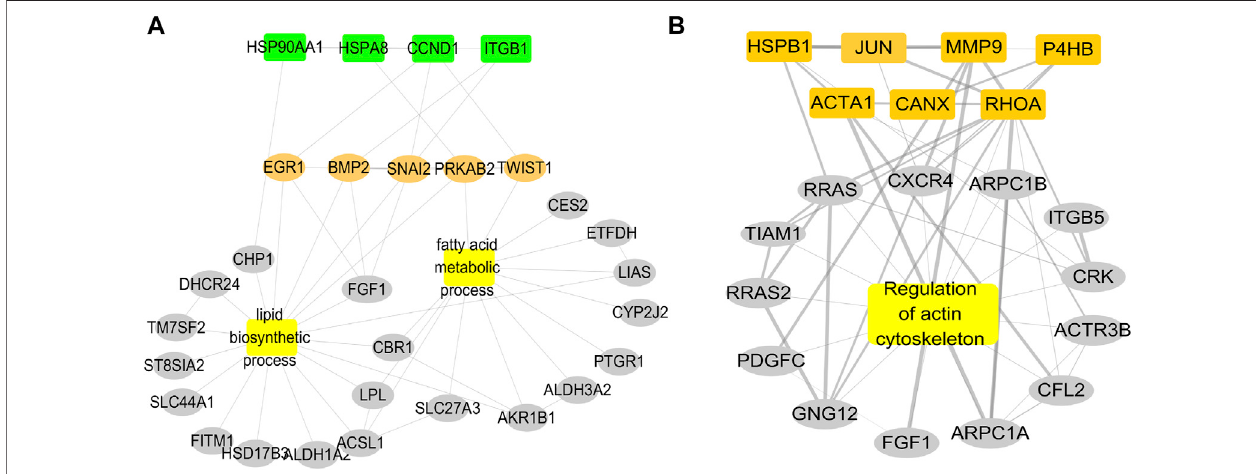
FIGURE 6 | Relationship of key genes with the lipid biosynthetic process and the fatty acid metabolic process. (A) PPI network of four key genes enriched in fatty acid metabolism and fatty acid synthesis interact. (B) PPI network of other seven key genes enriched in the actin process.